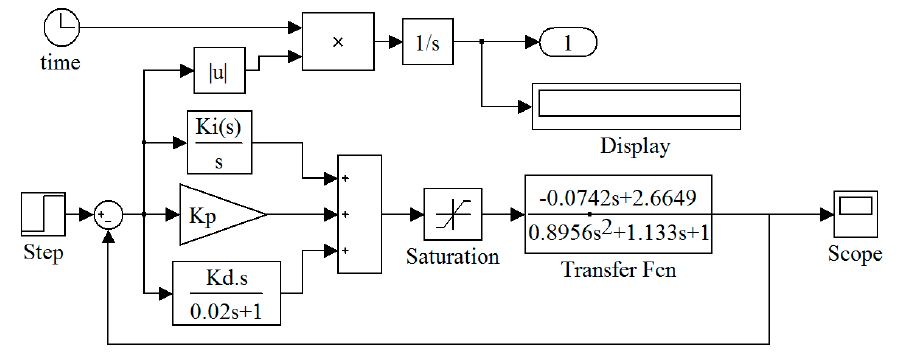
Figure 5. PID controller model.